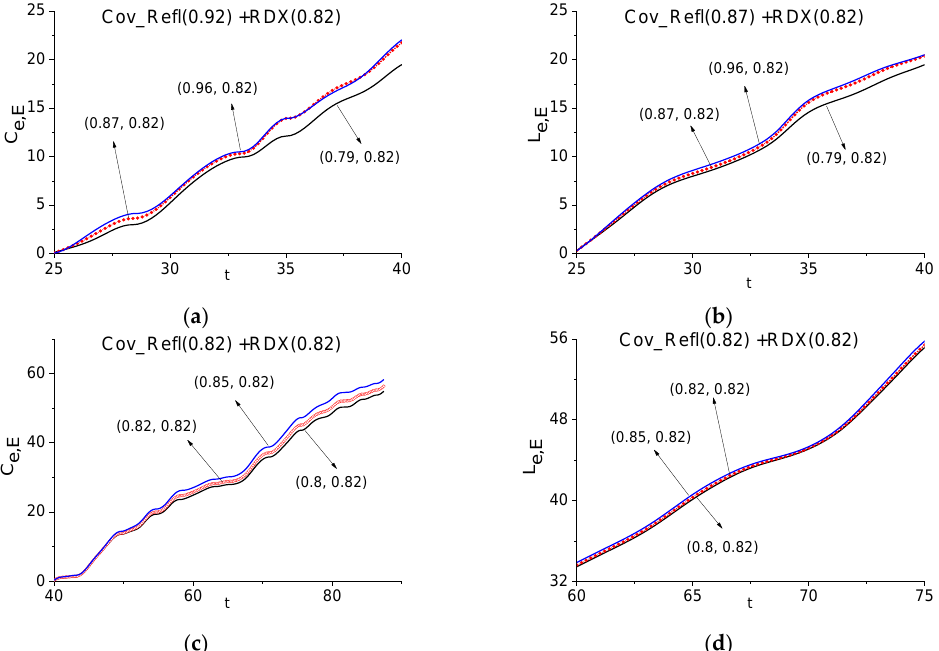
Figure 15. Time-dependent ICC C e,E ( a ), ( c ) and L e,E ( b ), ( d ) calculated for the frequencies ν = 0.87 ( a ), ( b ) and 0.82 ( c ), ( d ) during the time intervals t = [25, 40] ( a ), ( b ), [40, 90] ( c ), ( d ) for the signal reflected from the medium with covering (Cov_Refl) and the RDX_Air signal as a standard one.